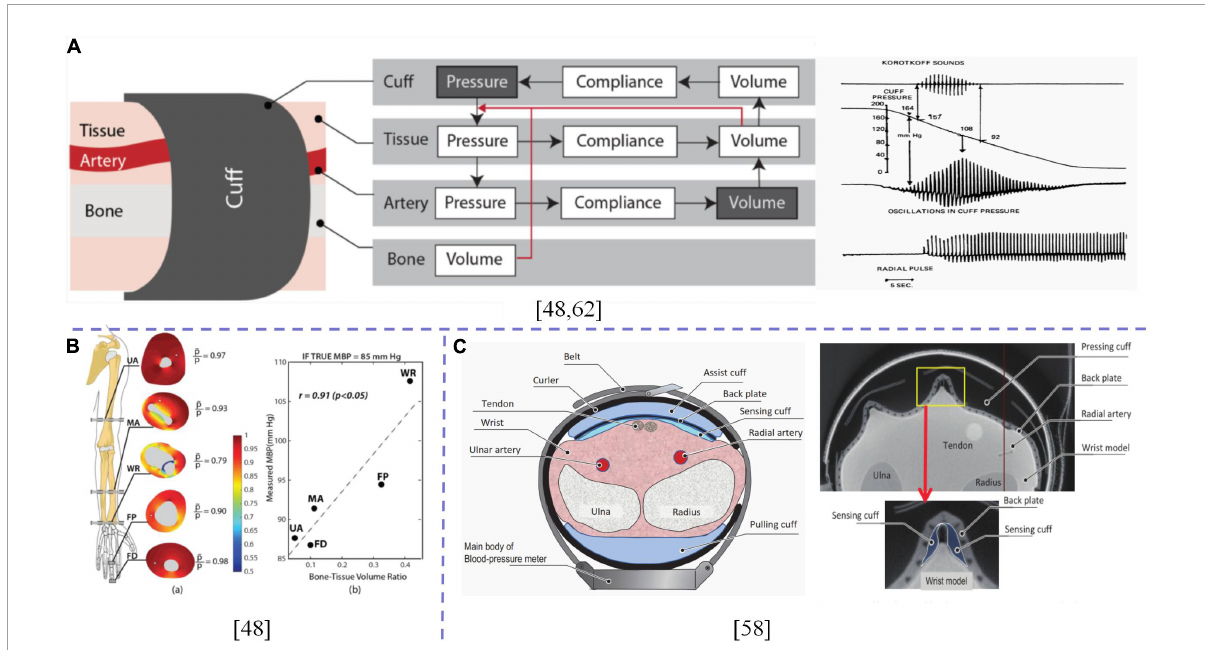
FIGURE2 (A) Working principle and chain of events of cuff-based oscillometric BPM; (B) Simulation of pressure distribution in the tissue, scatter plot of the measured MBP and bone-tissue volume ratio when the true MBP was assumed to be 85 mmHg; (C) Cross-sectional view of cuff structure. X-ray CT image of a sensing cuff bent under pressure of approximately 300 mmHg when a wrist simulator was compressed. The dotted lines are used to distinguish between different contents.